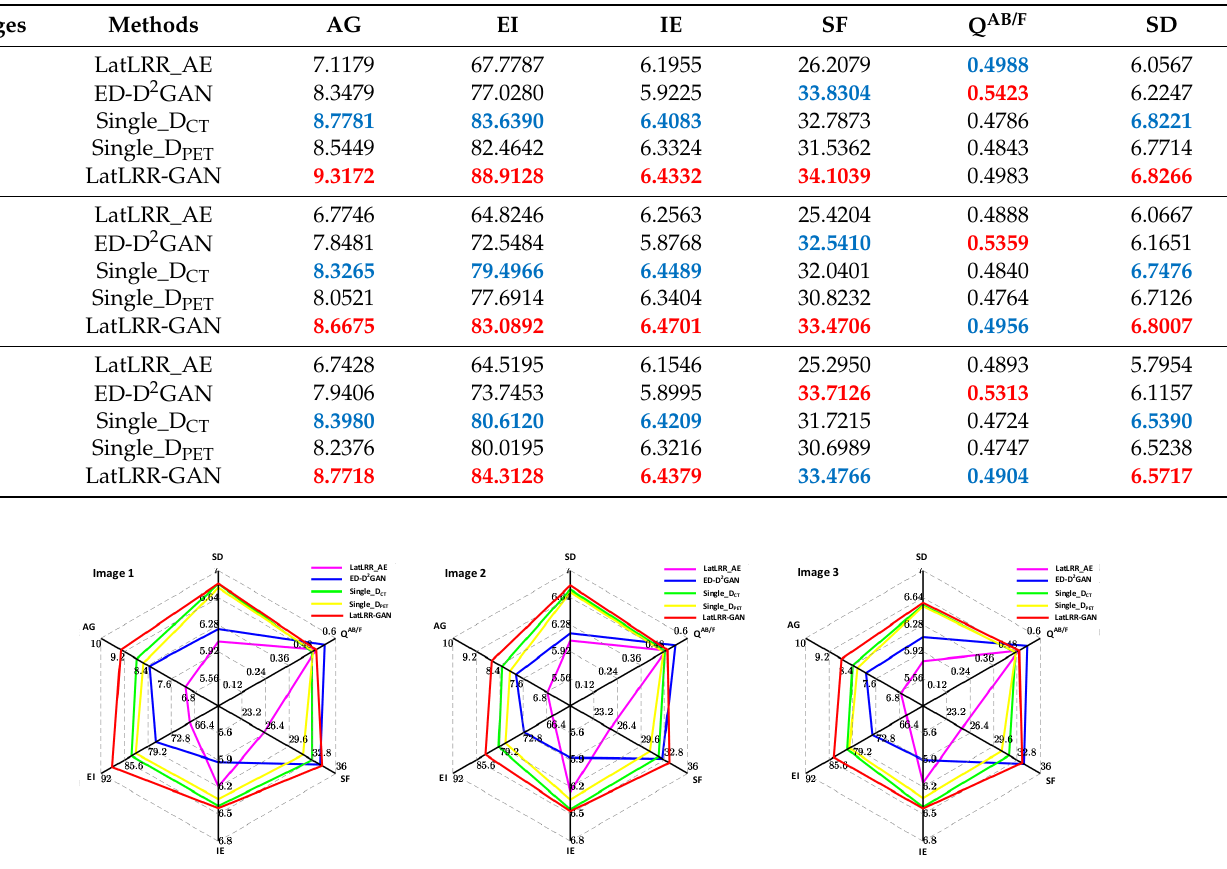
Table 4. The results of fused images’ evaluation metric values of CT mediastinal window images and